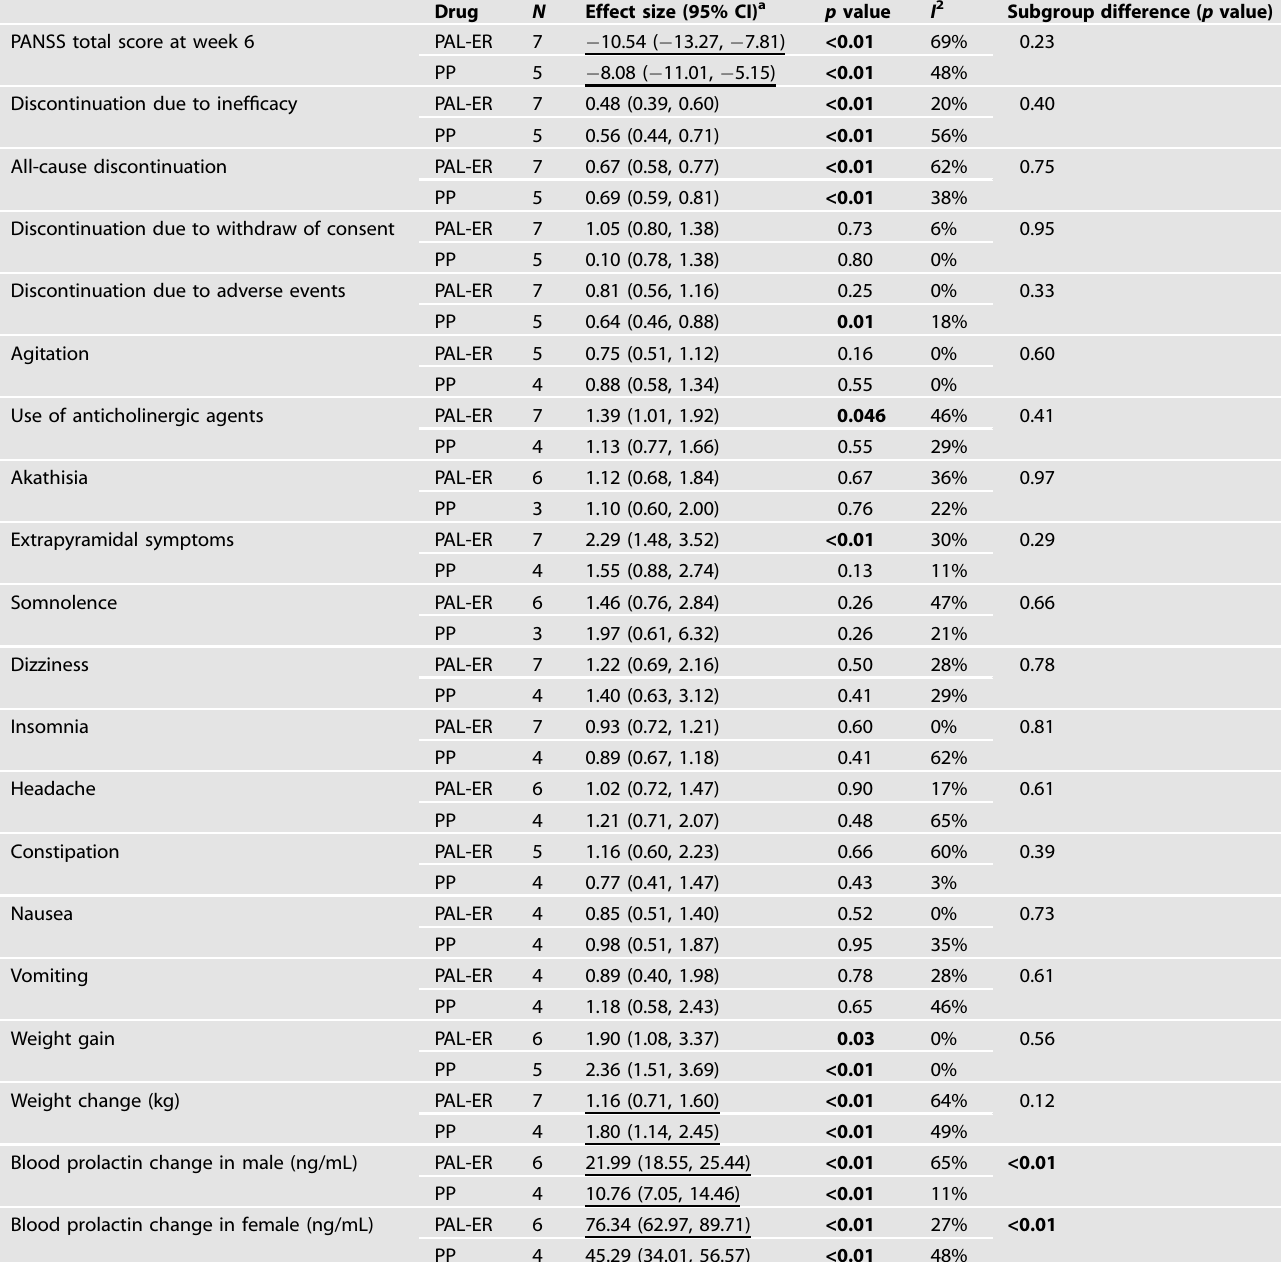
Table 1. The result of the pairwise meta-analysis and the test for subgroup